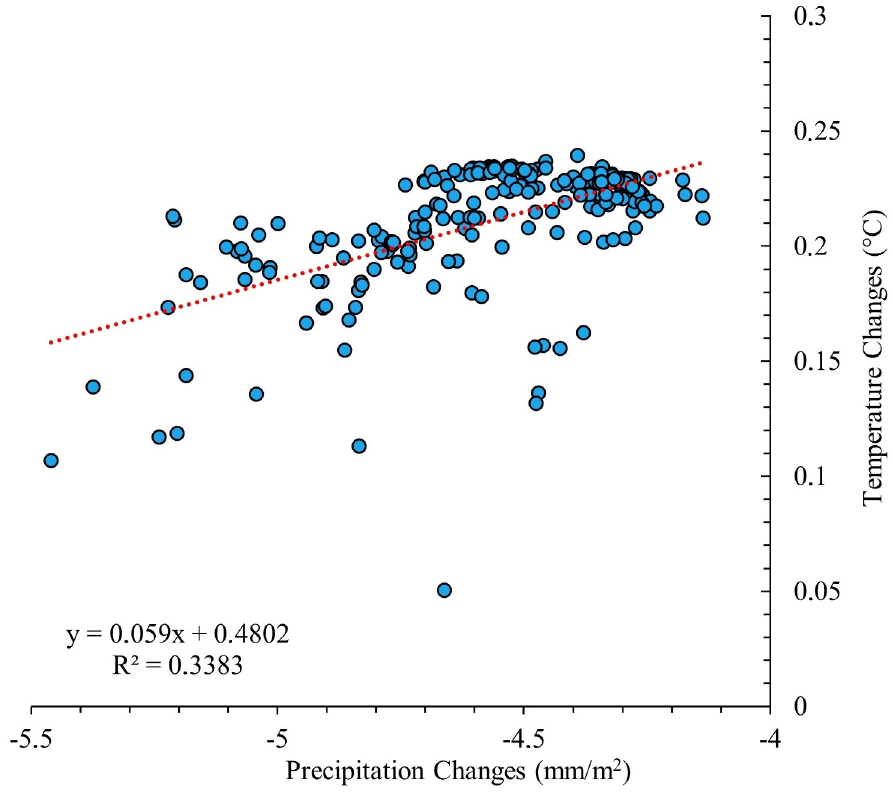
Figure 6. Changes in the amount of precipitation and temperature over the study